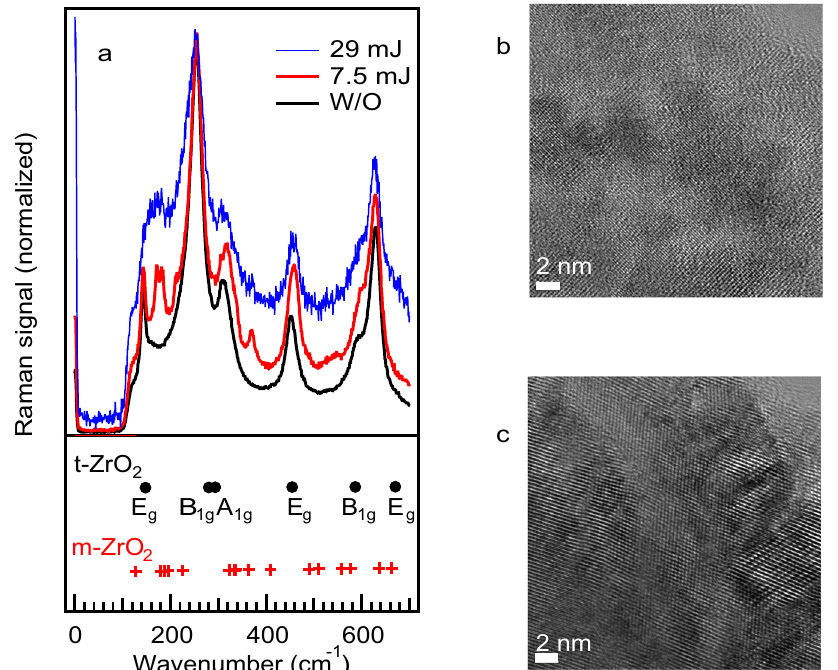
Fig. 3 Characterization of the atomic structure at different irradiation spots. a Raman spectra at the center positions of irradiation scars generated by excitation pulse energies of 29 (blue curve) and 7.5 mJ (red curve). The reference Raman spectrum without the irradiation (W/O) is shown by the black curve. The lower panel shows the Raman-active modes of t- and m-ZrO 2 30 . b TEM image of the t-ZrO 2 sample before irradiation. c TEM image of a sample region that was irradiated with a weak 4.2-THz FEL